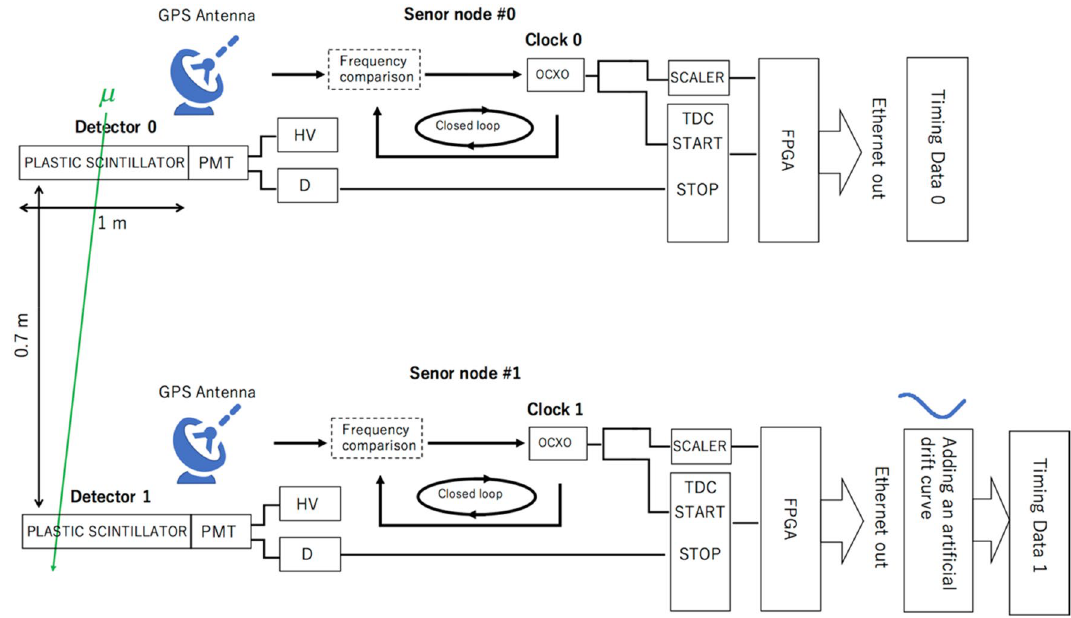
Figure 2. Block diagram of the CTC setup. The CTC Module 0 (top) and the CTC Module 1 (bottom) were setup with a vertical interval of 0.7 m. An artificial drift curve was added to the Clock 1 output. Timing Data 0 and Timing Data 1 were compared to check if this drift curve can be accurately